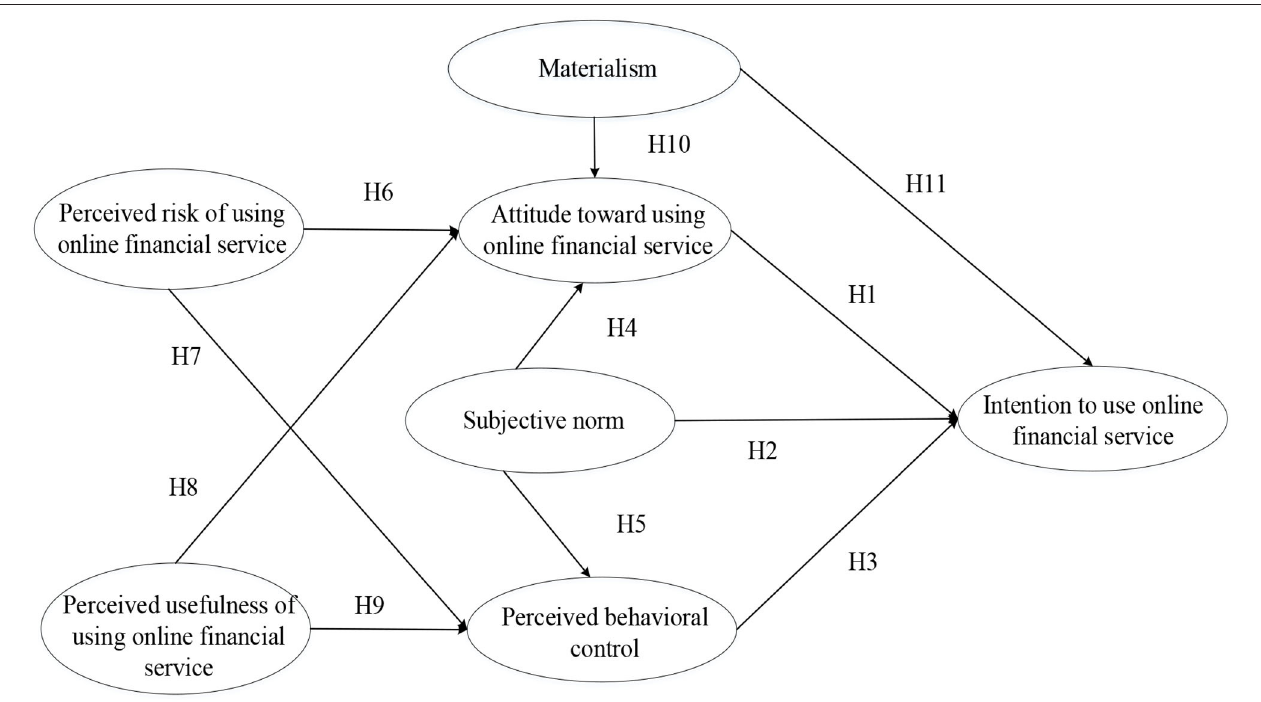
FIGURE 1 | The research